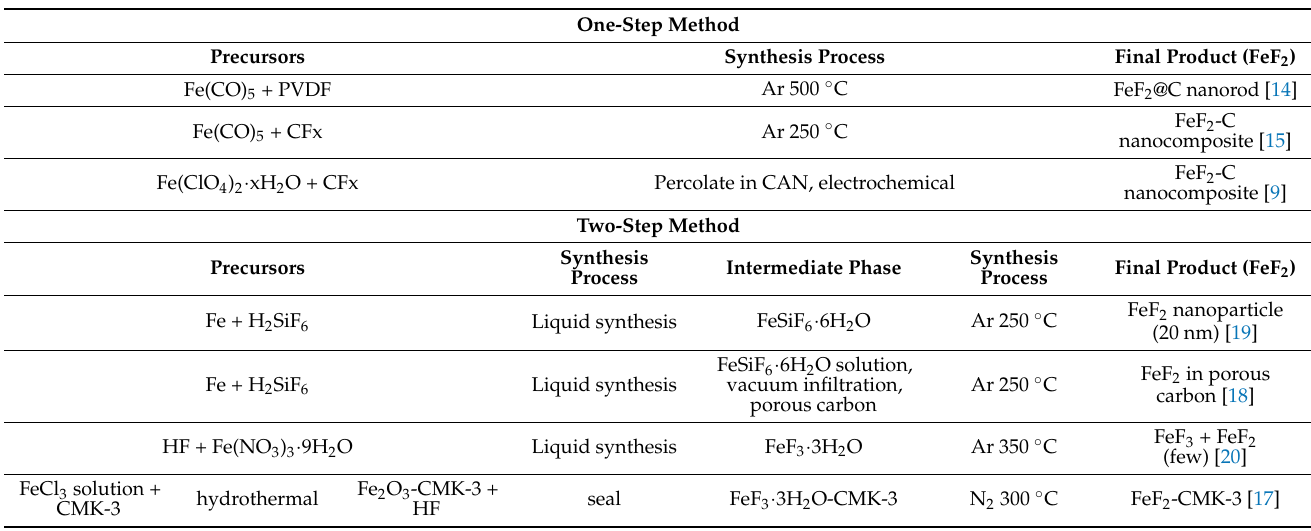
Table 1. Summary of the existing synthesis methods of FeF 2